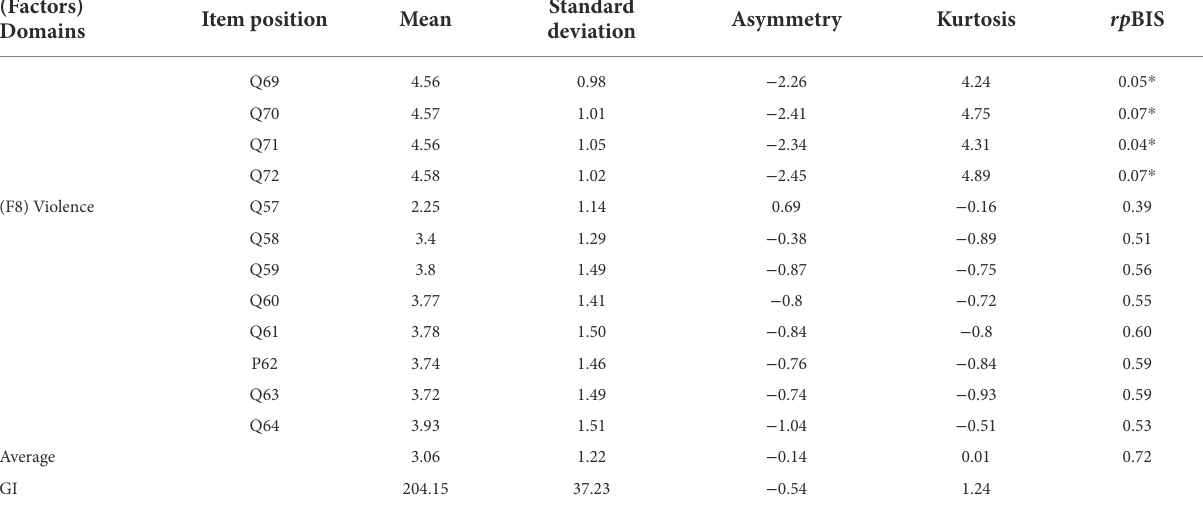
TABLE 4 Internal consistency indices for the factors and global instrument of the IIA-PRF provided by the STPS.